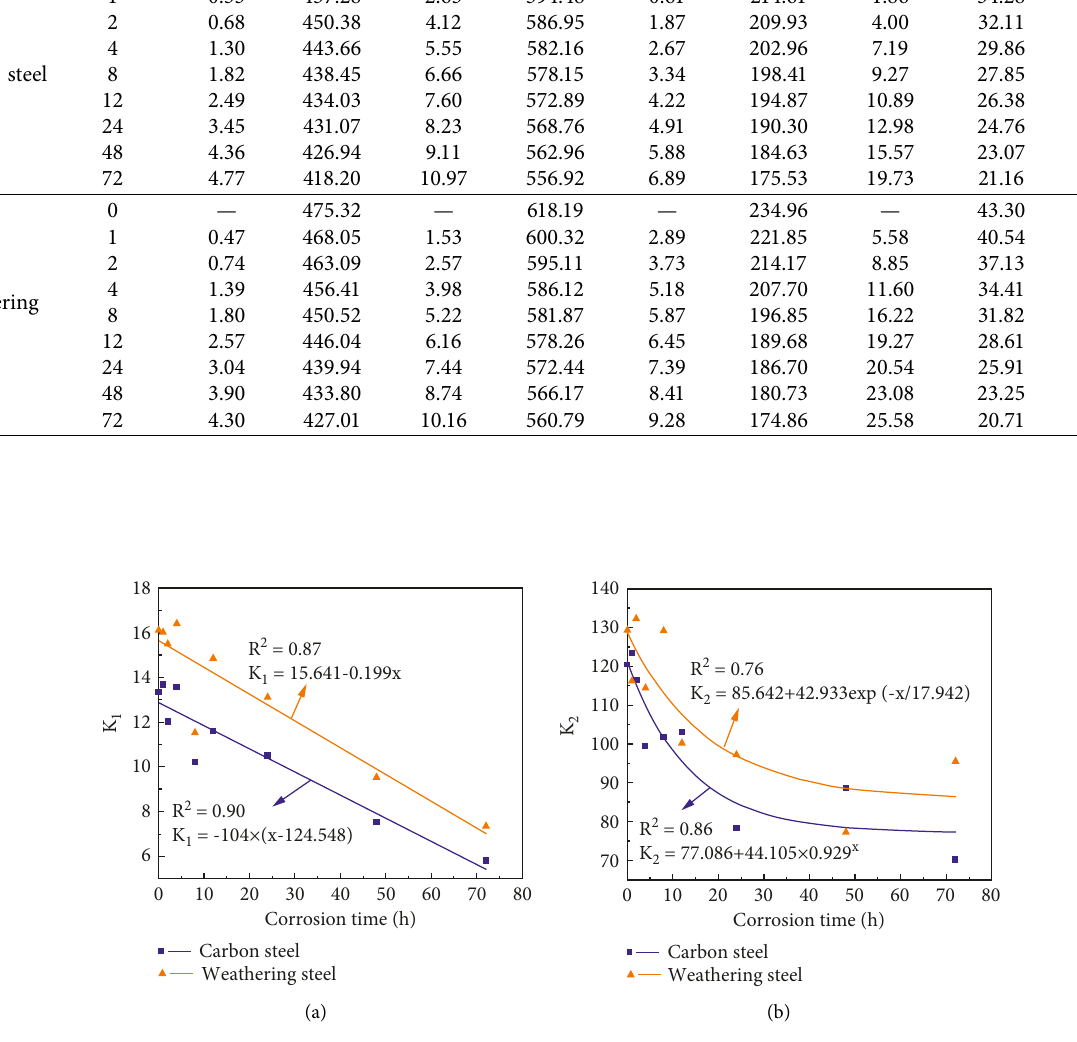
Figure 15: Relationships between K 1 (a) and K 2 (b) and corrosion time for carbon and weathering steels.